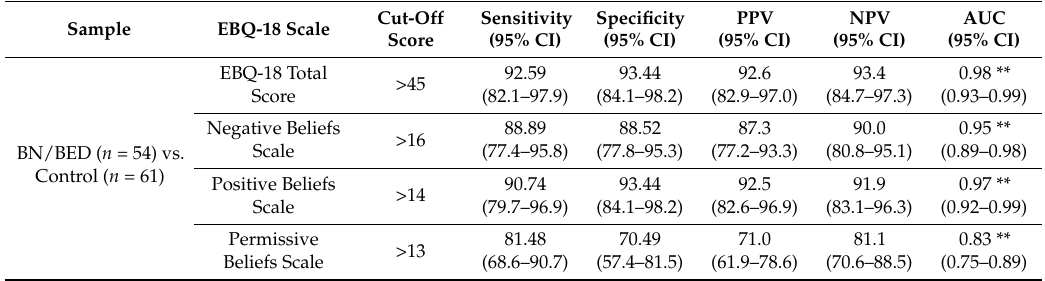
Table 7. Results from ROC Curve Analyses for EBQ Total and subscale scores.